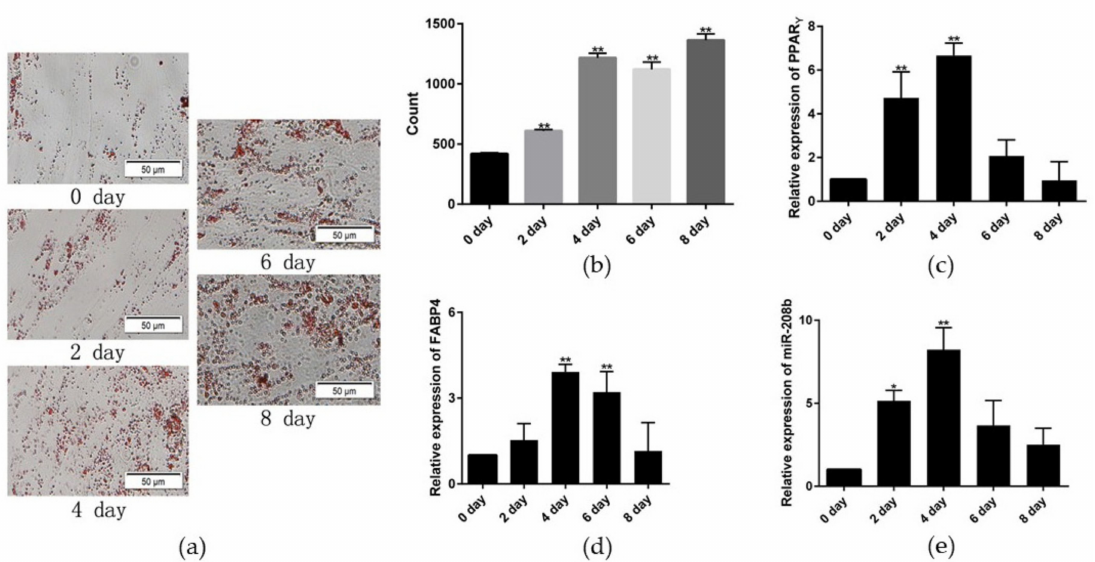
Figure 1. Establishment of rabbit preadipocyte differentiation model. ( a ) Oil Red O staining of lipid droplets at 0, 2, 4, 6, and 8 days of differentiation. ( b ) The number of lipid droplets ( n = 3). ( c , d ) The relative expression levels of PPAR γ and FABP4 in rabbit preadipocyte after inducing differentiation at 0, 2, 4, 6, and 8 days. ( e ) The relative expression levels of miR-208b during preadipocyte differentiation progress. The data are presented as means ± SEM ( n = 9). * p < 0.05; ** p <